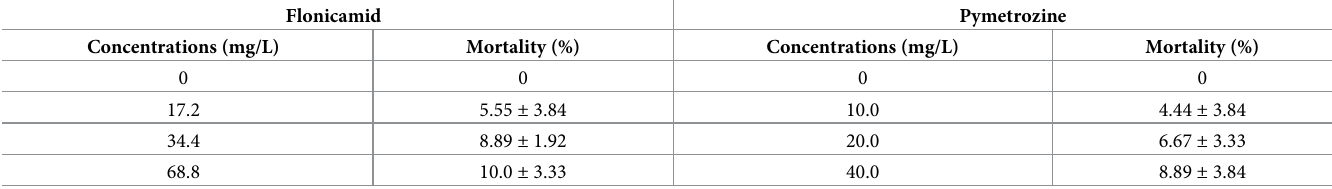
Table 2. Mortality of M . persicae after exposure to different doses of flonicamid and pymetrozine for 24